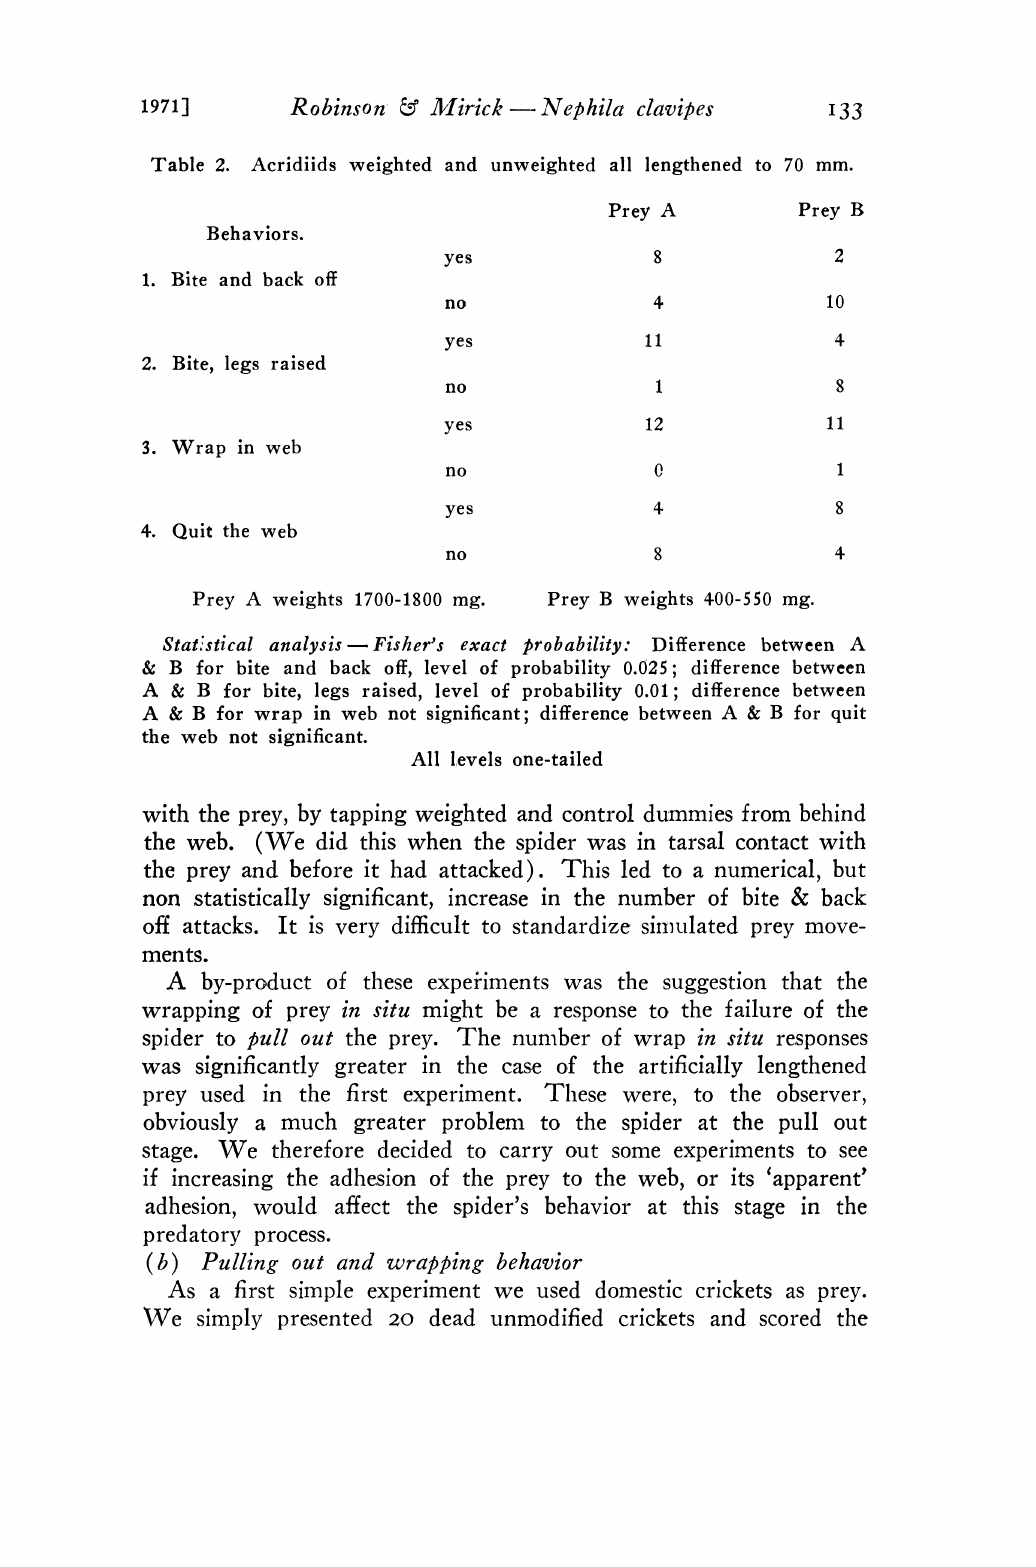
Table 2. Acridiids weighted and unweighted all lengthened to 70 mm.